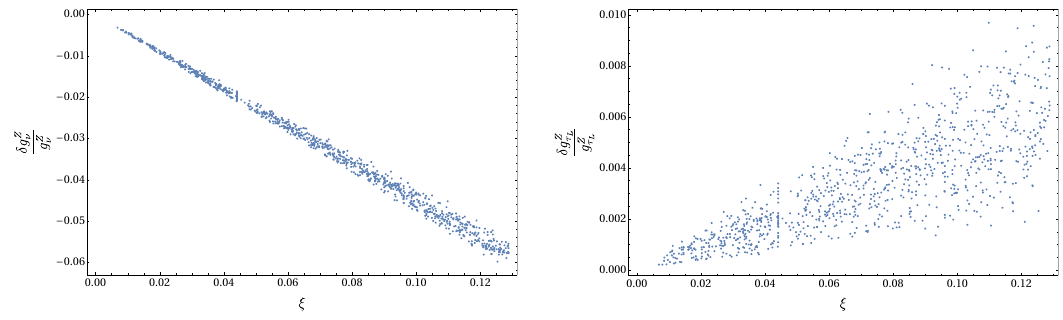
Figure 5 . Relative correction of the couplings Z(cid:23) (cid:22) (cid:23) on the left panel, and Z(cid:28) L (cid:22) (cid:28) L on the right panel, as a function of (cid:24) , for points in the benchmark